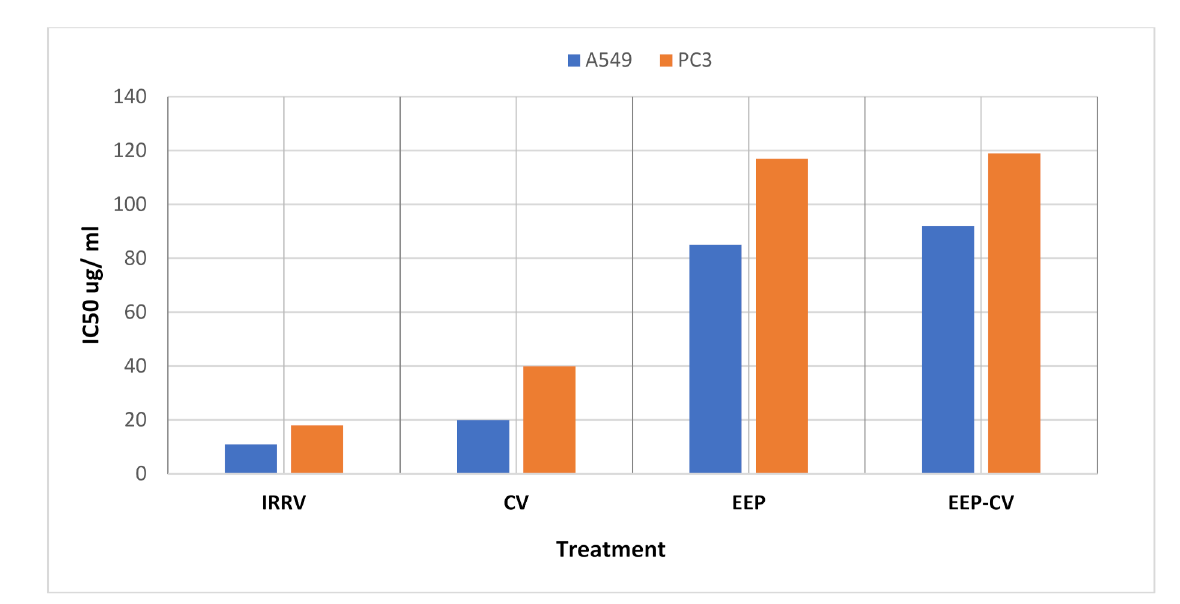
Figure 2. Evaluation of IC 50 of CV, IRRV, and PEE against [PC3]&[A549]cell lines using